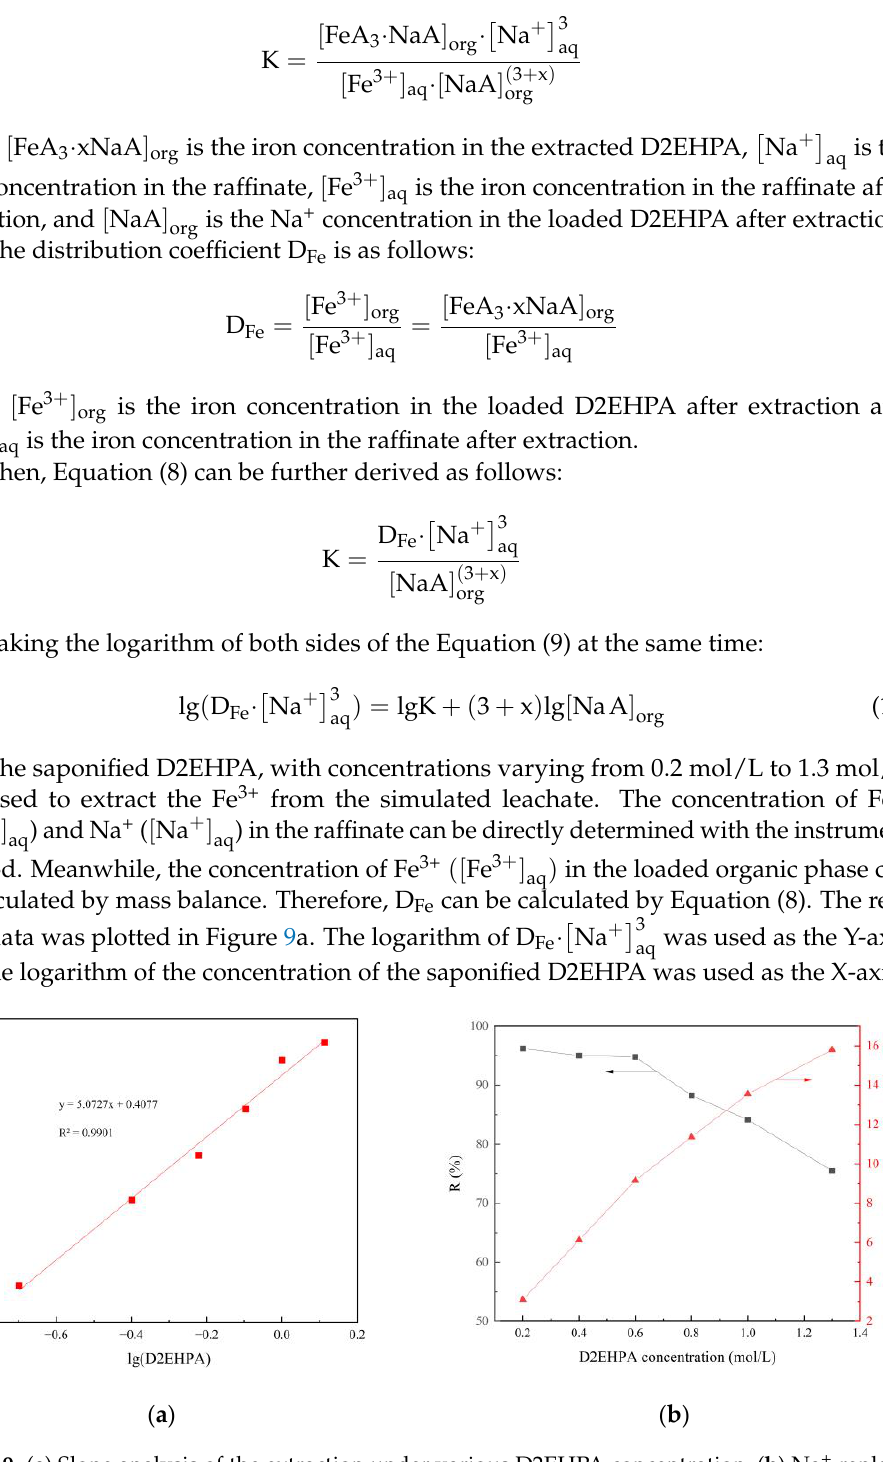
Figure 9. ( a ) Slope analysis of the extraction under various D2EHPA concentration, ( b ) Na + replace- ment after extraction under various D2EHPA